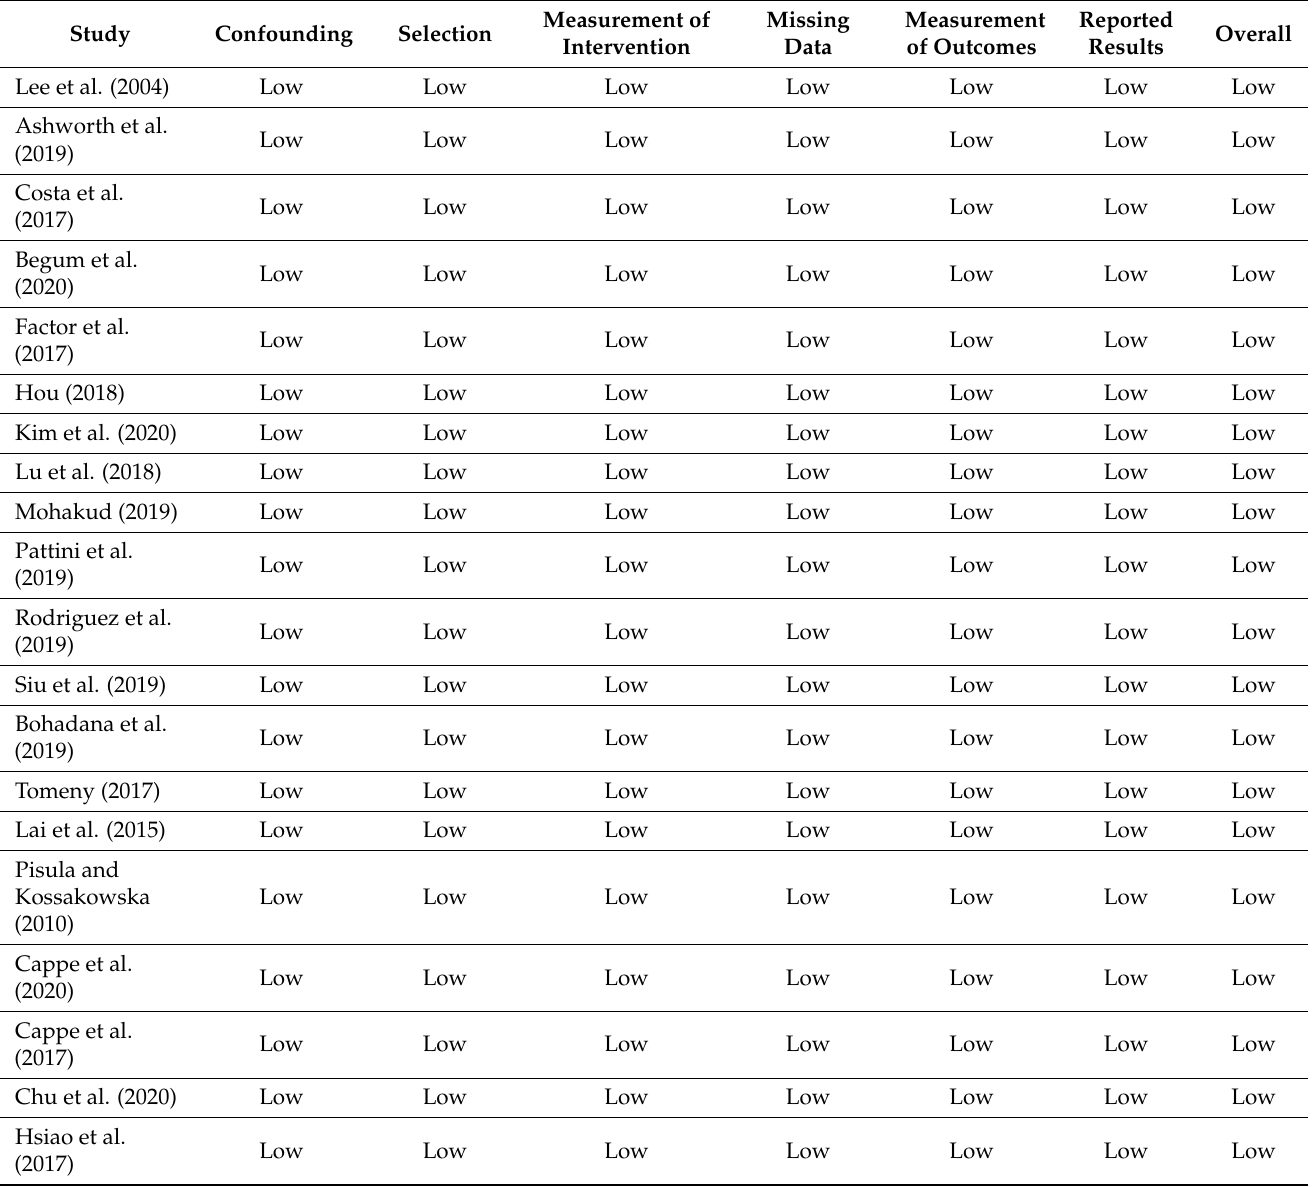
Table A1. Risk of bias